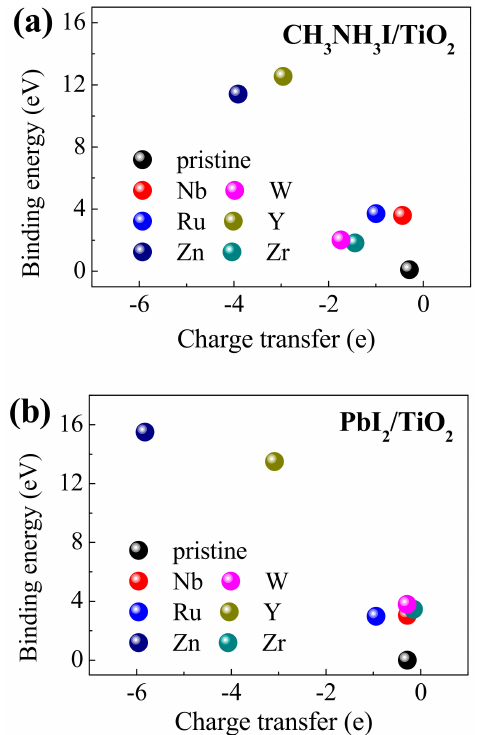
Figure 3. Relationship between the interfacial charge transfers and binding energies of transition metal-substituted CH 3 NH 3 PbI 3 / TiO 2 : ( a ) CH 3 NH 3 I / TiO 2 ( b ) PbI 2 / TiO 2